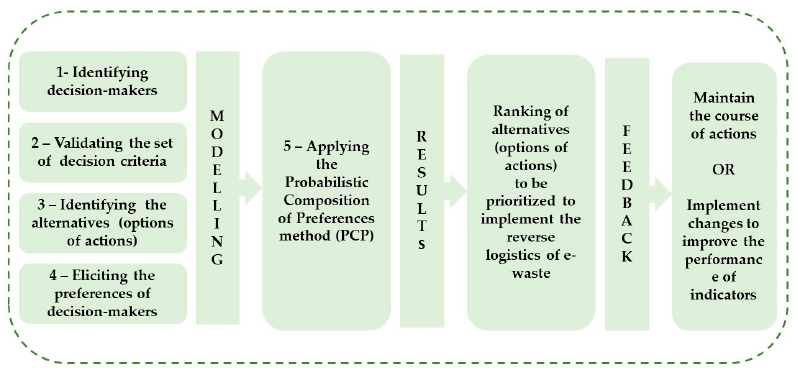
Figure 8. Model to assess the implementation of the reverse logistics of e-waste considering a multicriteria perspective.